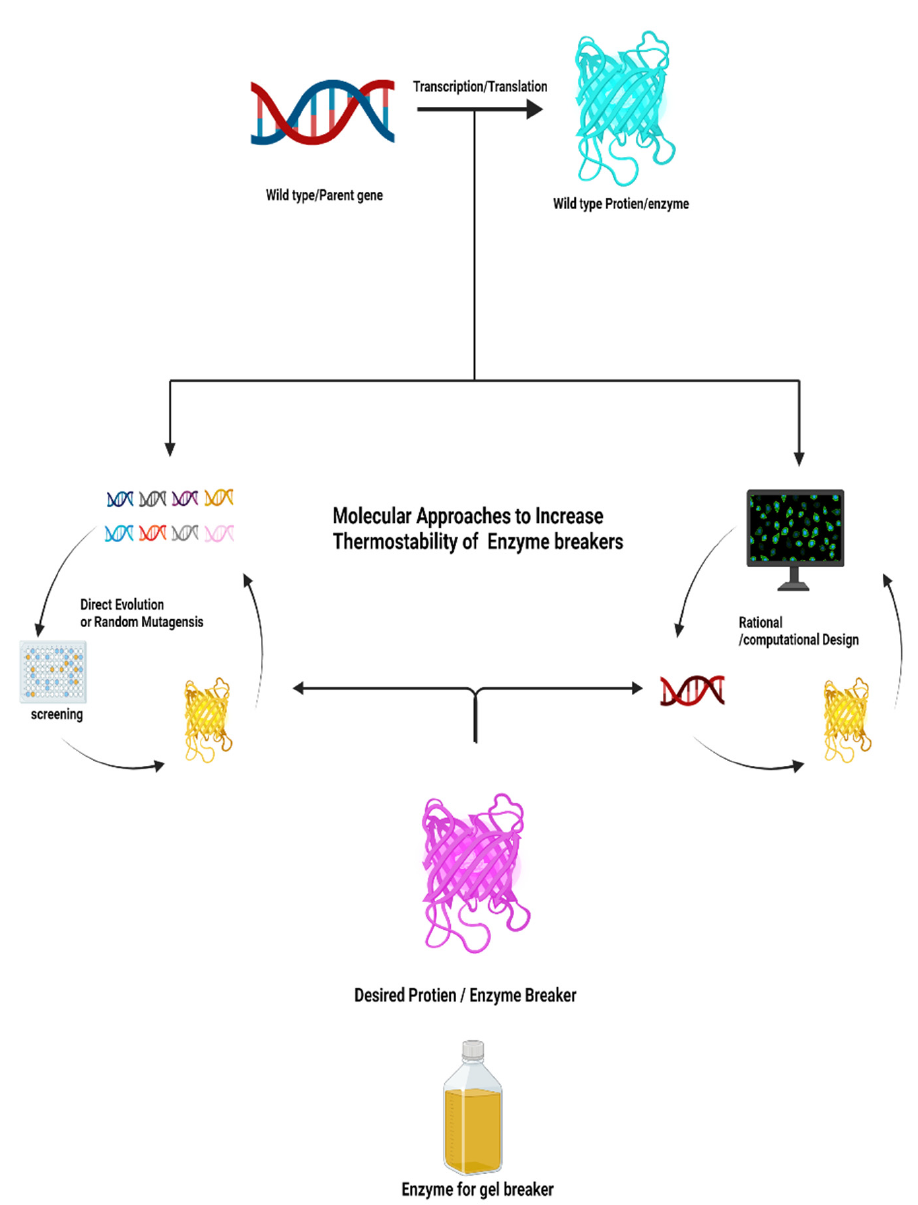
Figure 1. Abstract overview of molecular approaches used to increase the thermostability of enzyme breaker, created by https://biorender.com web tool.